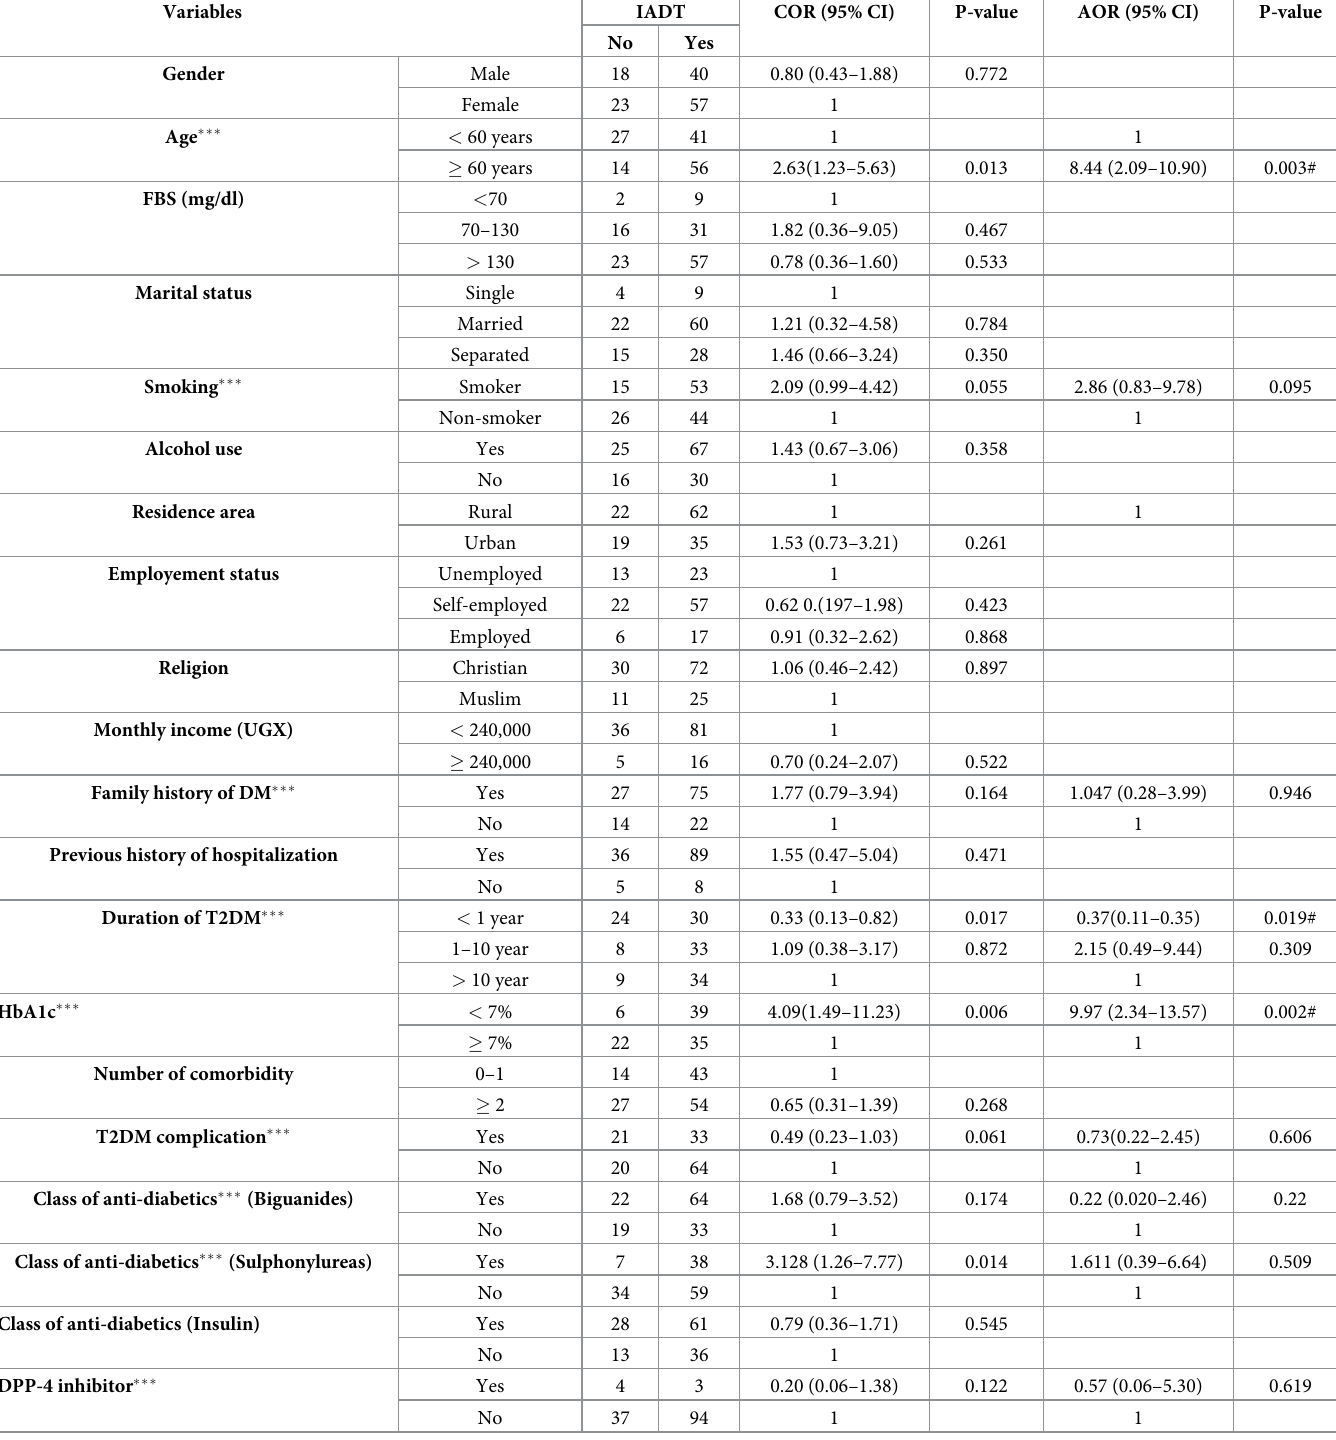
Table 4. Logistic regression analysis of the association between independent variables and IADT among T2DM patients at medical and surgical wards of MRRH from November 2021 to January 2022, Mbarara,